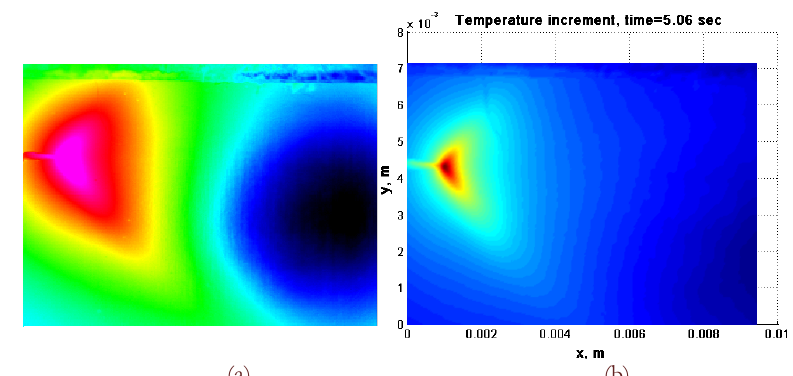
Figure 3: Infrared image of the specimen with crack before data processing (a) and the obtained temperature increment field (b) . Calculation of stored energy under quasistatic loading